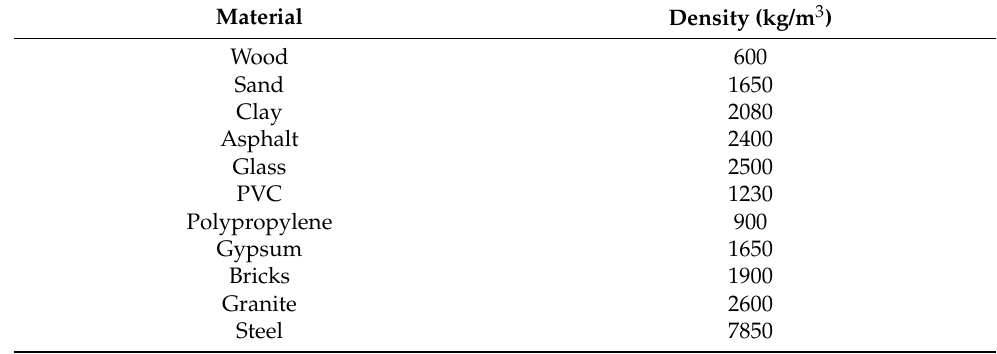
Table 3. The density of the particle on the road